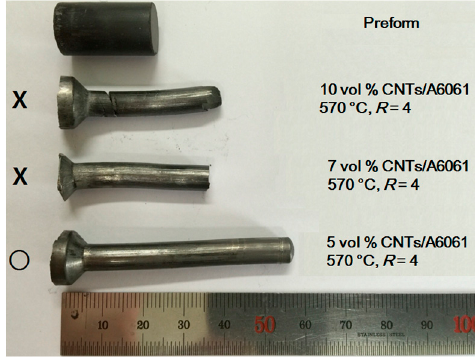
Figure 5. The preform and billets formed by the hot extrusion process.